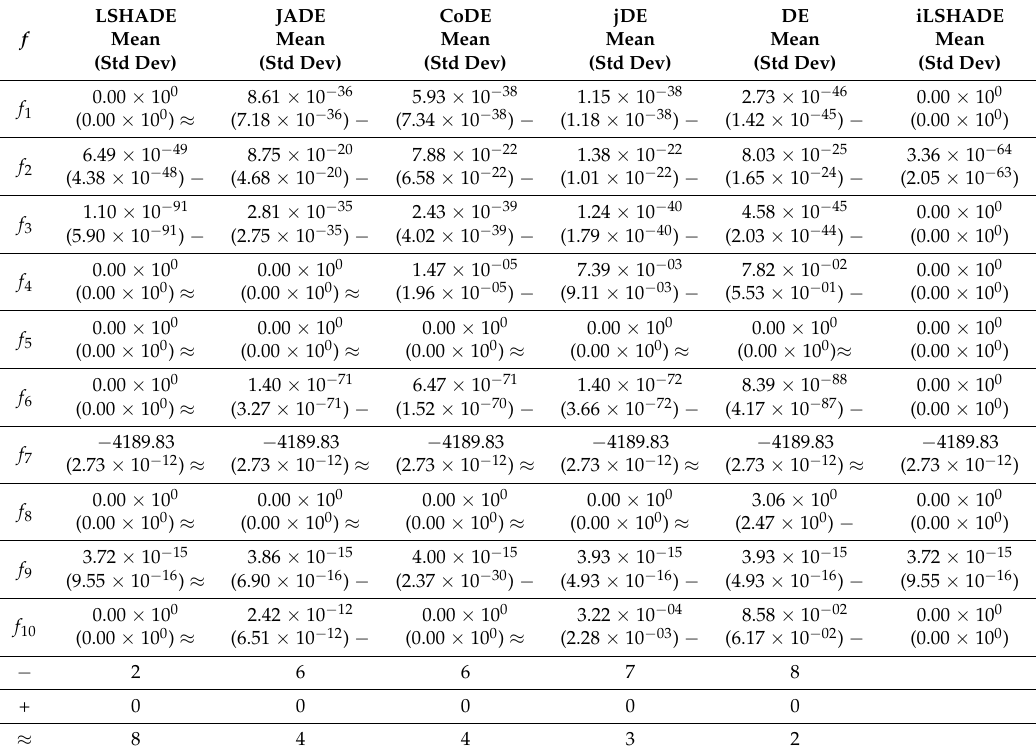
Table 2. Experimental results of 10 test functions in low dimension.